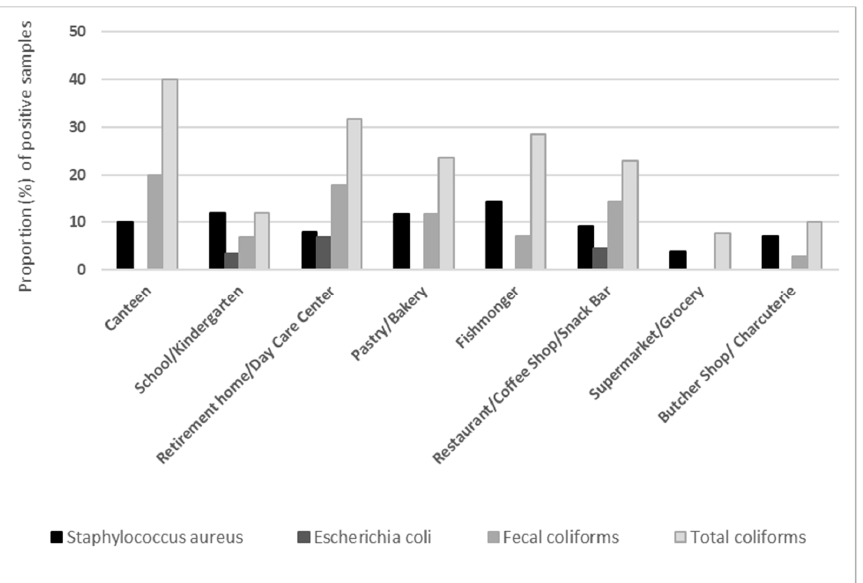
Figure 3. Proportion of positive samples for each group of microorganisms assessed in samples taken from hands of food